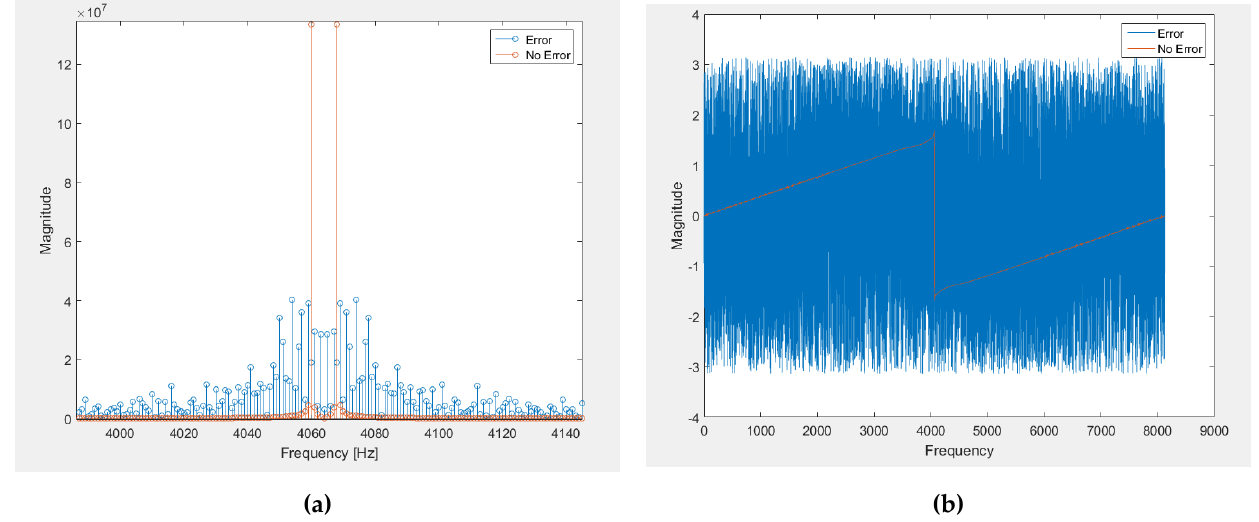
Figure 3. ( a ) Receiver’s Magnitude in presence of a SEU and ( b ) Receiver’s Phase presence in of a SEU.